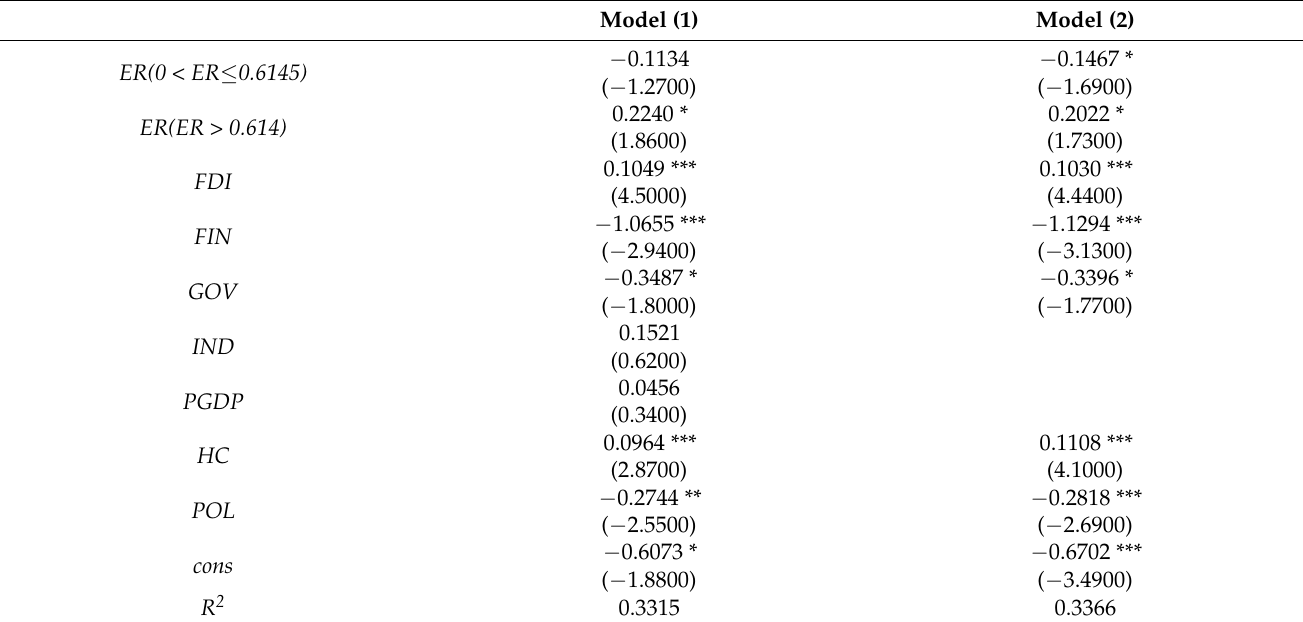
Table 11. The consequences of the threshold